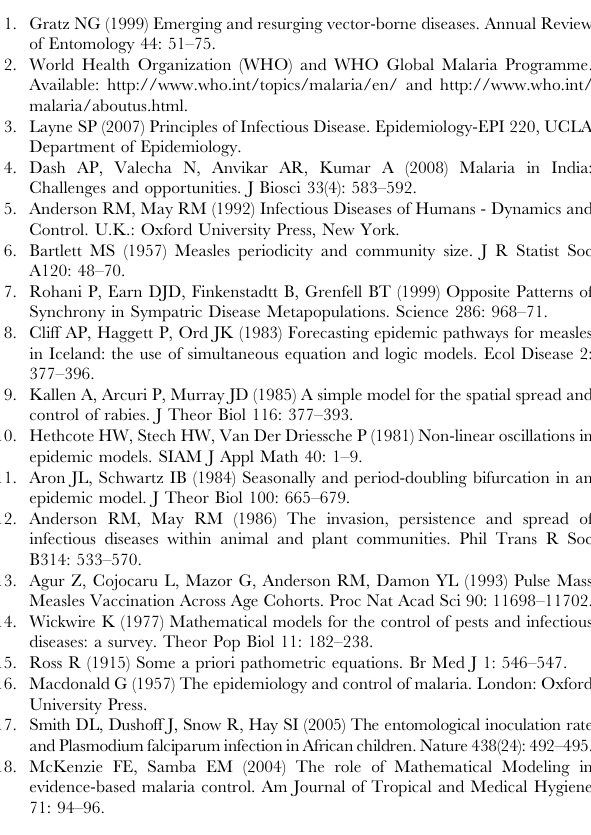
Table S2 Rotated component matrix (Varimax Rotation